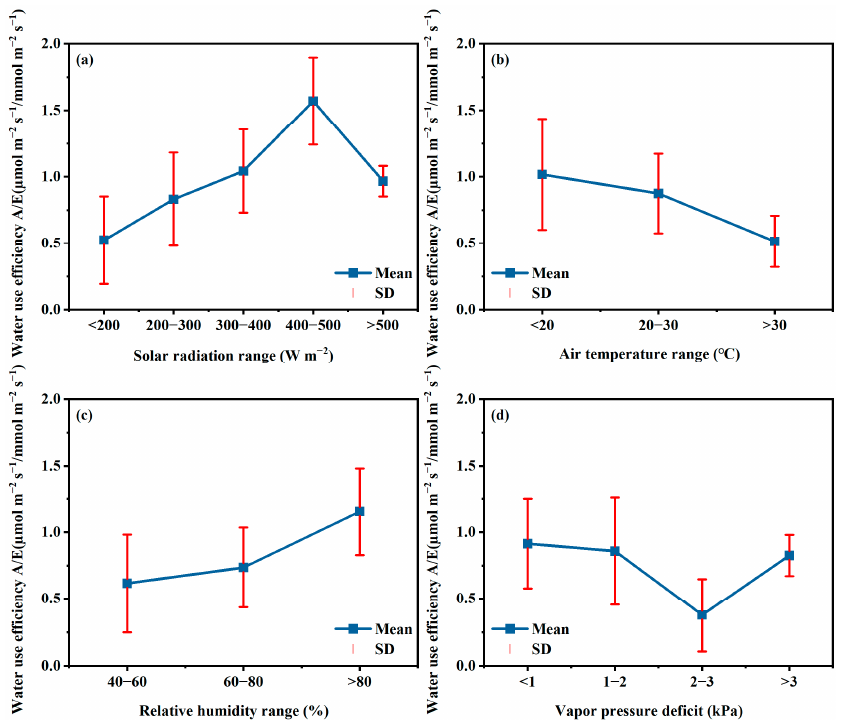
Figure 8. The relationships between water use efficiency at leaf level to solar radiation ( a ), air temperature ( b ), relative humidity ( c ), and vapor pressure deficit ( d ).